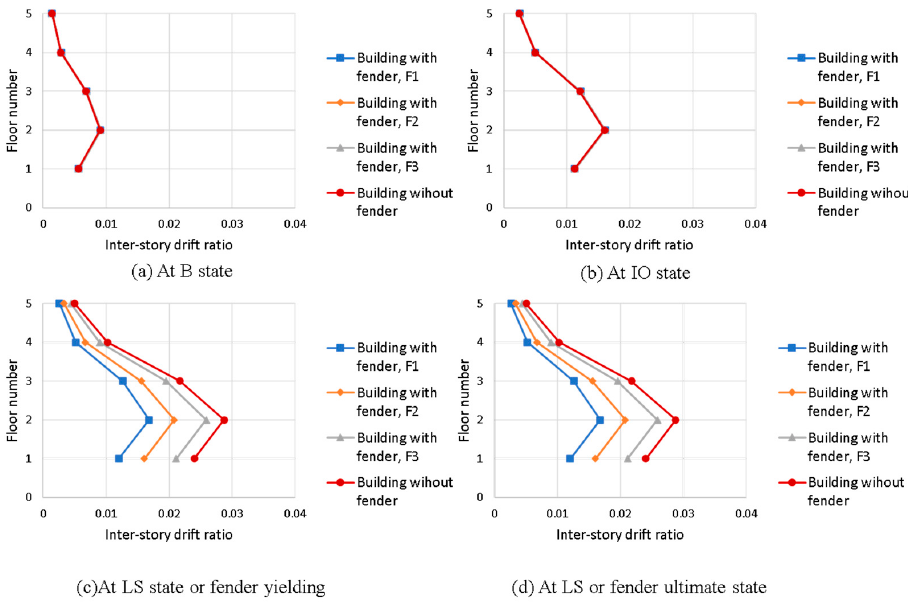
Figure 17. Inter-story drift ratios of the buildings.